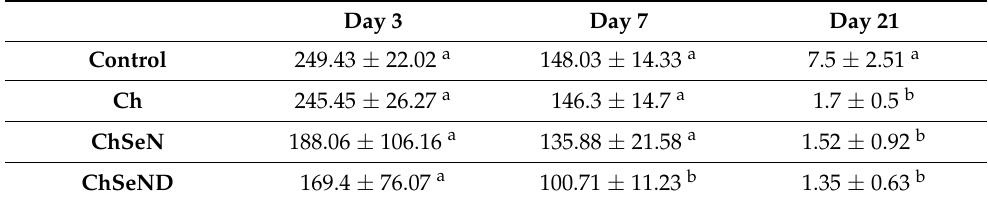
Table 5. Comparison of the mean ( ± SEM) of wound area (mm 2 ) in different